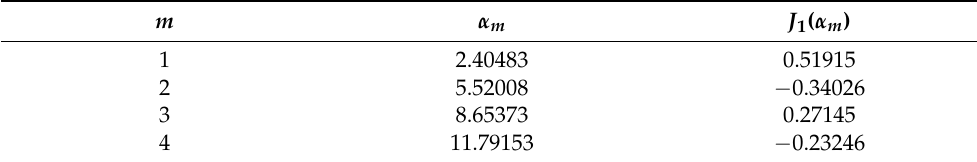
Table 1. Values of α m and the first-order Bessel functions of the first kind for modes 1–4 [15]. m α